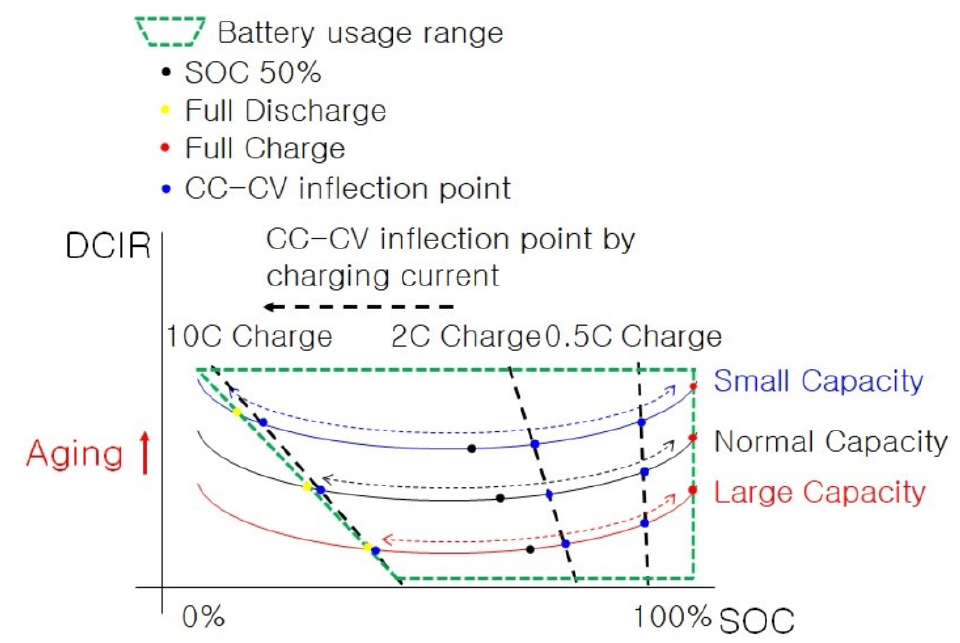
Figure 10. Battery usage area using the proposed cell balancing